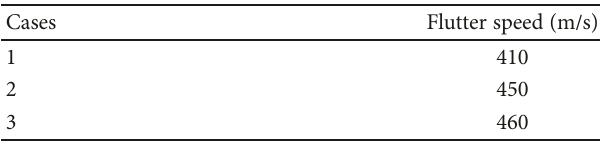
Table 6: Comparison of the critical fl utter